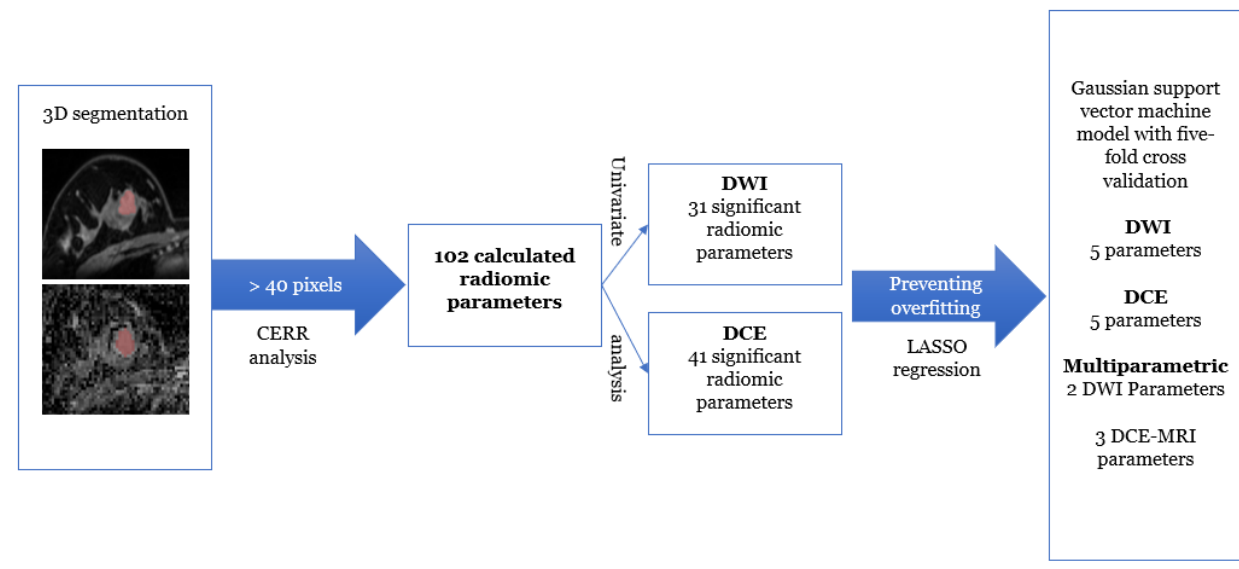
Figure 3. Workflow for the radiomics analysis. DCE-MRI, dynamic contrast-enhanced MRI; DWI, diffusion-weighted imaging; CERR, Computational Environment for Radiological Research; LASSO, least absolute shrinkage and selection operator. Table 3. Diagnostic metrics for the performance of the machine learning (ML) models for each dataset. Dataset